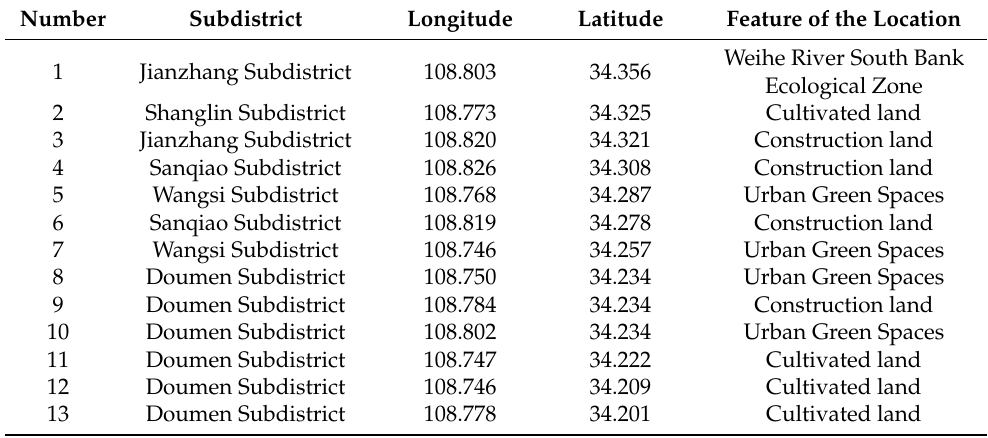
Table 5. Distribution of ecological